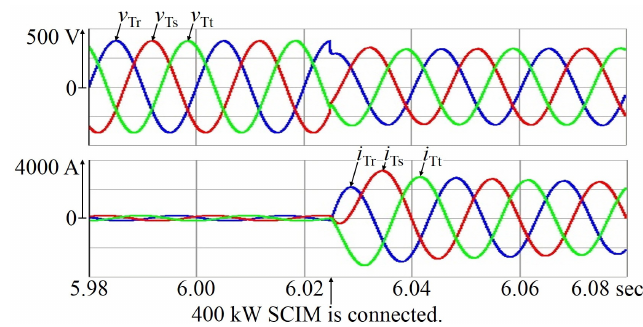
Figure 9. Magnified waveforms for Figure